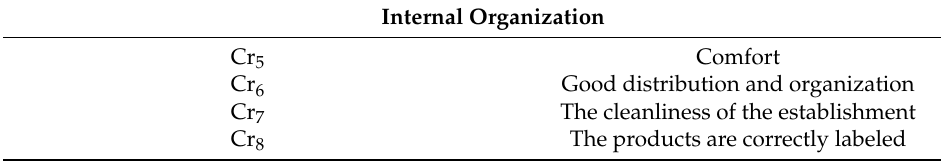
Table 4. Internal organization.